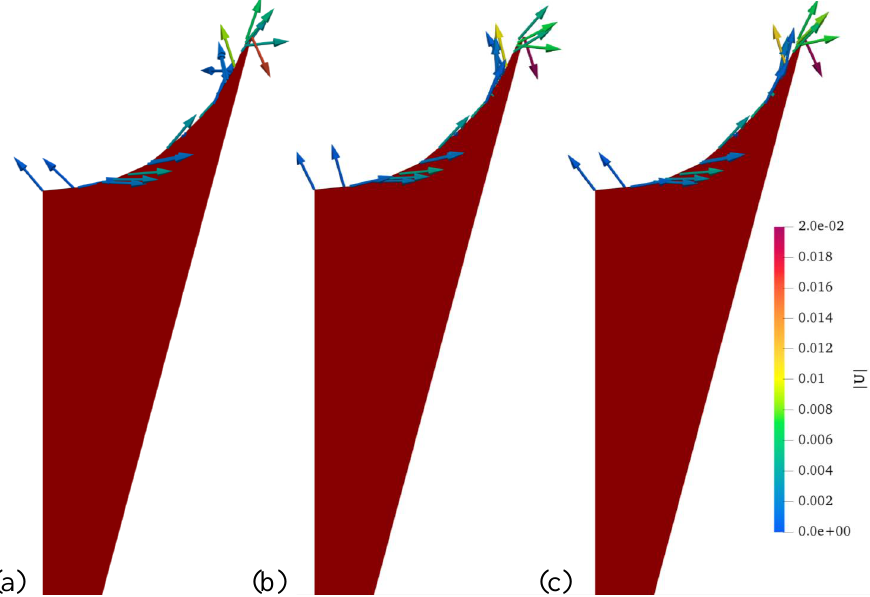
Figure 7. Part of ICF-1 cross-sectional slice with liquid (red) in equilibrium, normalized velocity | U | interfacial vectors with colorbar magnitude (not pertaining to solid red liquid) at ( a ) 0 s, ( b ) 10 s, and ( c ) 20